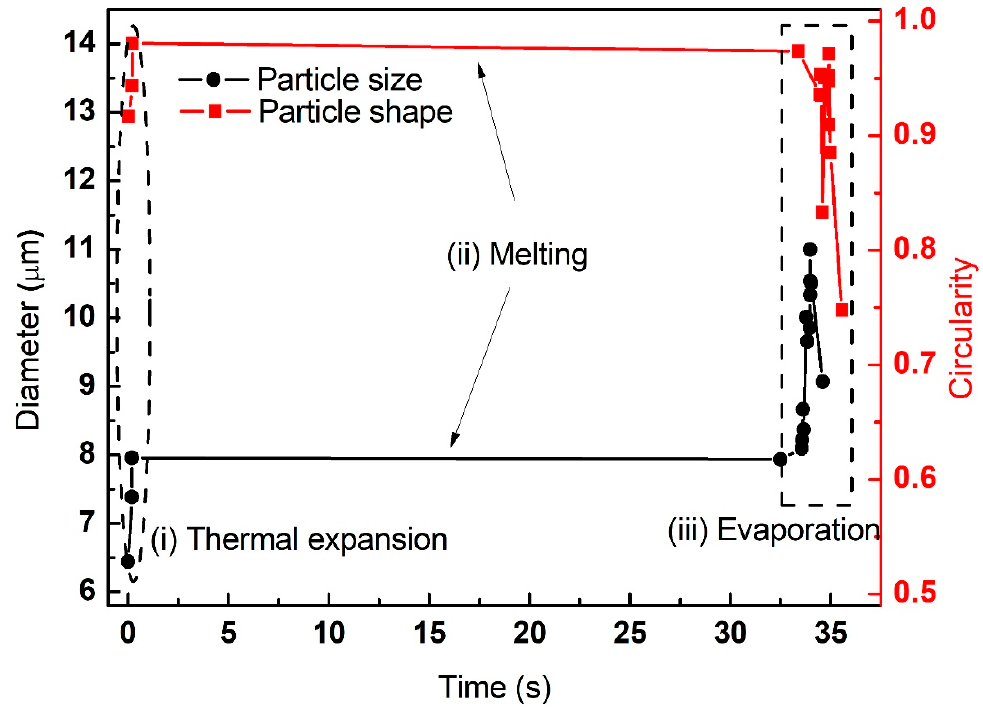
Figure 7. The variation of particle diameter and circularity of individual aluminum particles (initial diameter of 6.82 μ m, laser power density of 5.88 × 10 5 W/cm 2 ).